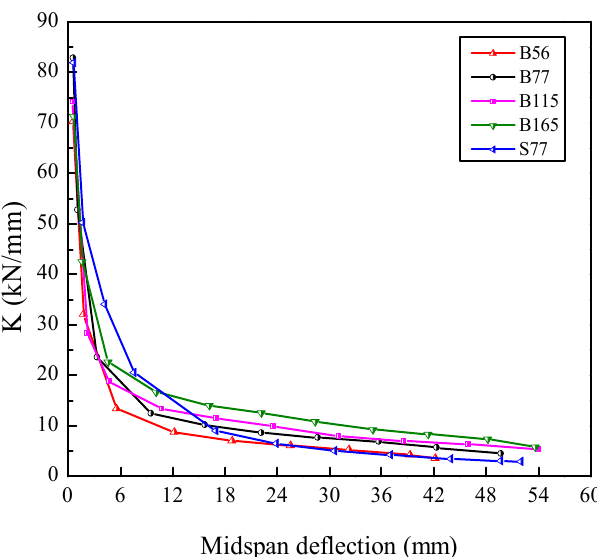
Figure 13. Equivalent stiffness degradation.